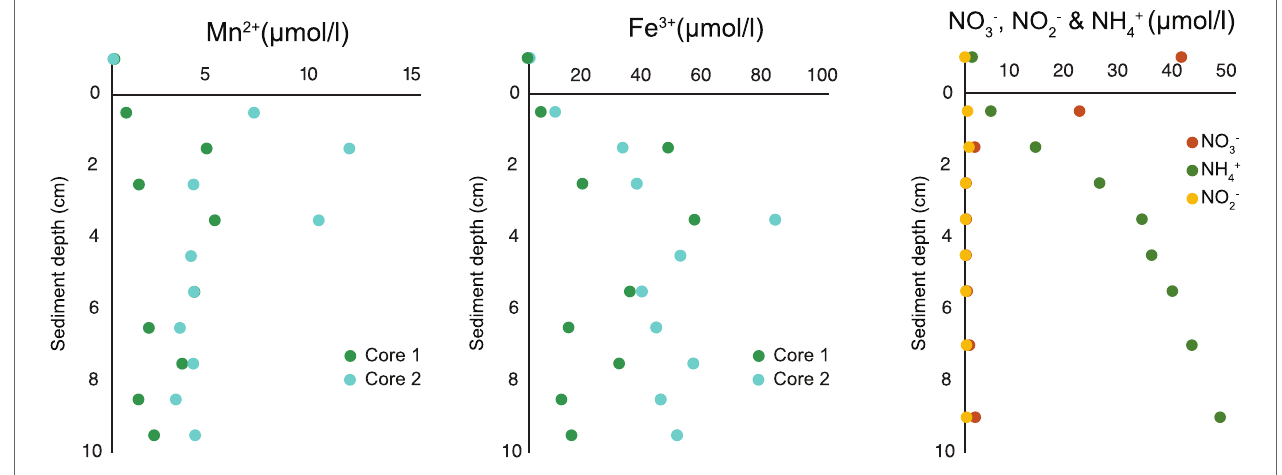
FIGURE 2 | Porewater profiles of manganese and iron (2017) and nitrate, nitrite, and ammonium (2019) in 0–10 cm sediment